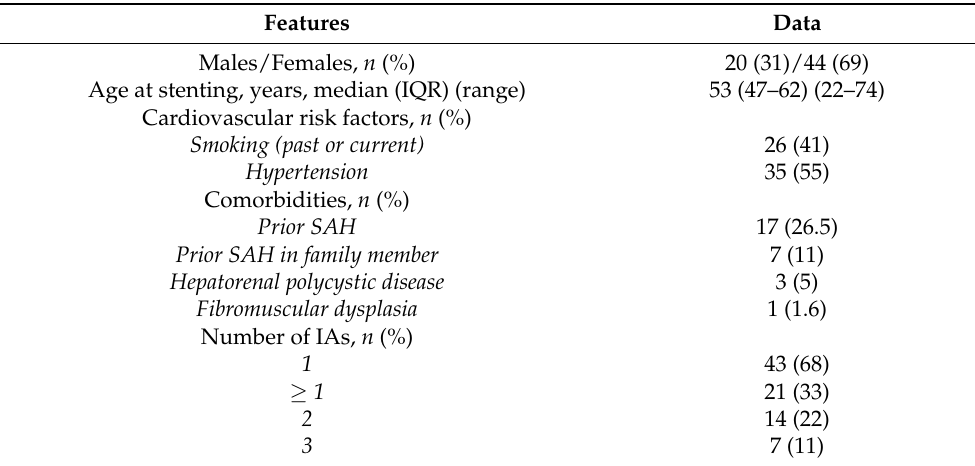
Table 1. Main features of the 64 patients.